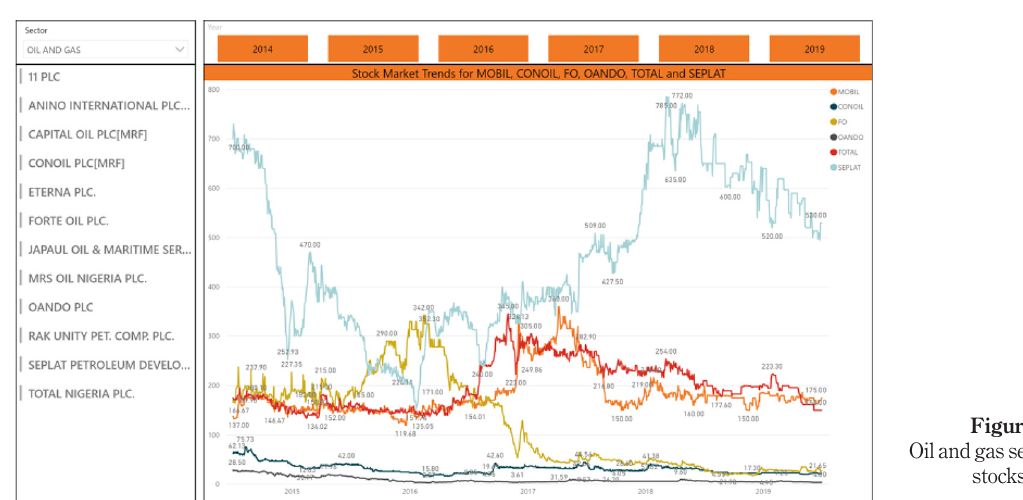
Figure A6. Oil and gas selected stocks trend